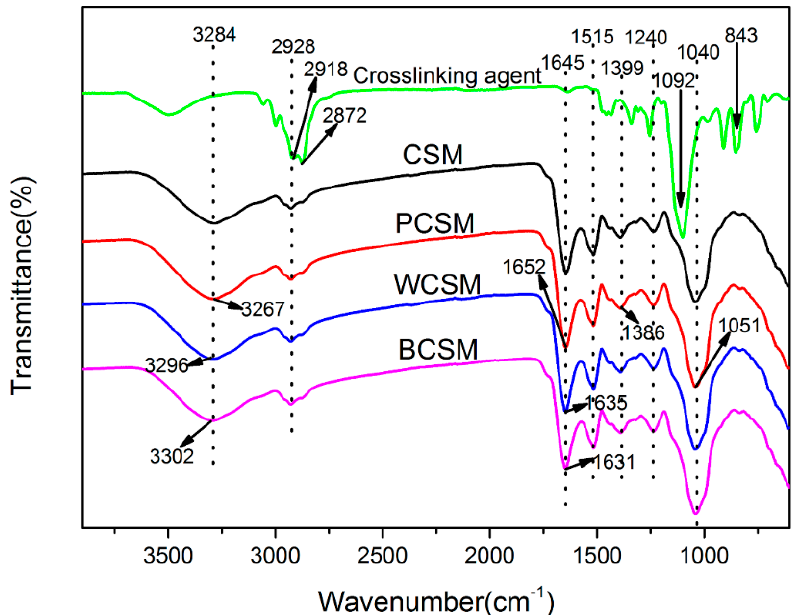
Figure 1. ATR spectra of CSM, PCSM, WCSM, and BCSM adhesives.